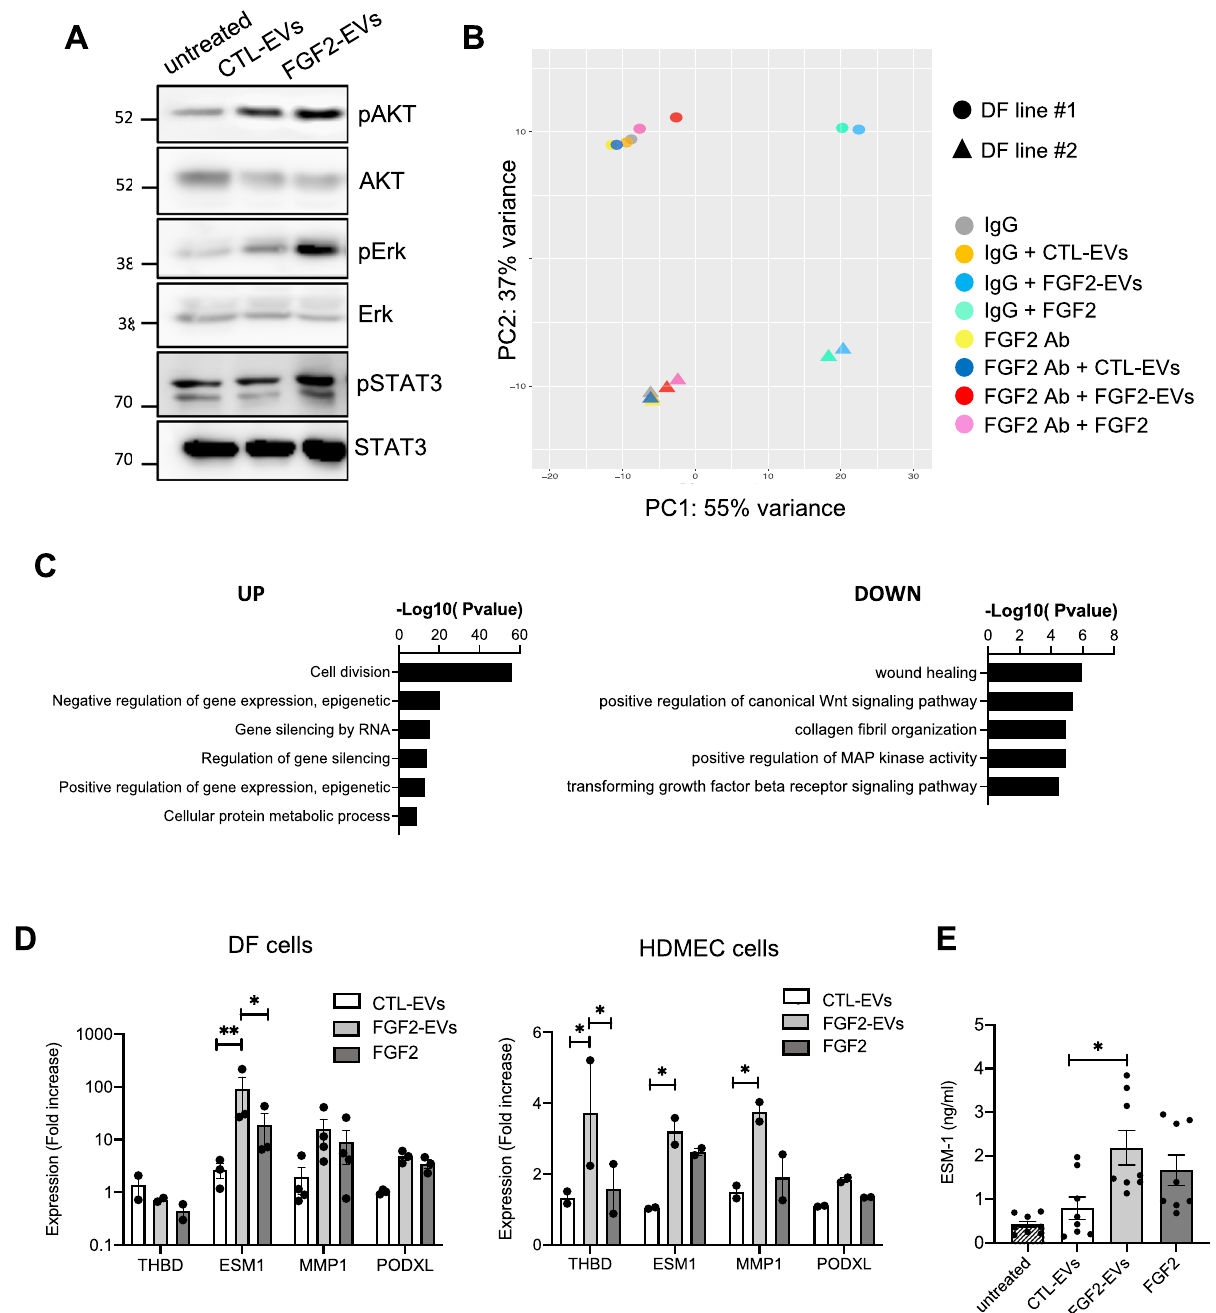
Figure 4. Activated pathways by FGF2-EVs in DF cells. ( A ) ERK, AKT and STAT pathways are activated by FGF2-EVs. DF cells were treated with CTL-EVs or FGF2-EVs (1E + 9p/ml) for 10 min and activation of ERK, AKT and STAT3 was revealed with the detection of phosphorylation forms by western blot from 20 μg proteins. Total forms of ERK, AKT and STAT3 proteins were also detected to assess total amount of protein. Representative blots are shown. Original blots are shown in Suppl. Information. ( B , C ) RNA-seq analysis after FGF2-EV treatment. Two DF cell lines were treated with PBS, CTL-EVs or FGF2-EVs (2E + 10p) or FGF2 (100 ng/ml) for 24 h, following which RNA-seq was performed. Additional samples were pre-treated with neutralizing FGF2 antibody or IgG control 1 h before EV treatment. ( B ) PCA plot ( C ) GO terms of upregulated and downregulated genes between CTL-EVs and FGF2-EVs. ( D ) Validation by RT-PCR. DF cells and HDMEC cells were treated with PBS, CTL-EVs, FGF2-EVs or recombinant FGF2 for 24 h and real-time PCR was performed with primers specific to THBD, ESM1, MMP1 and PODXL genes. The data are mean ± SE of 2–4 independent experiments. Statistical significance was determined by two-way ANOVA (multiple comparison test with Tukey correction), *< 0.05, **< 0.01. ( E ) Concentration of extracellular ESM-1 protein in conditioned medium of treated DF cells was determined by ELISA. The data are mean ± SE of four independent experiments. Statistical significance was determined by ordinary one-way ANOVA (multiple comparison test with Tukey correction). *<